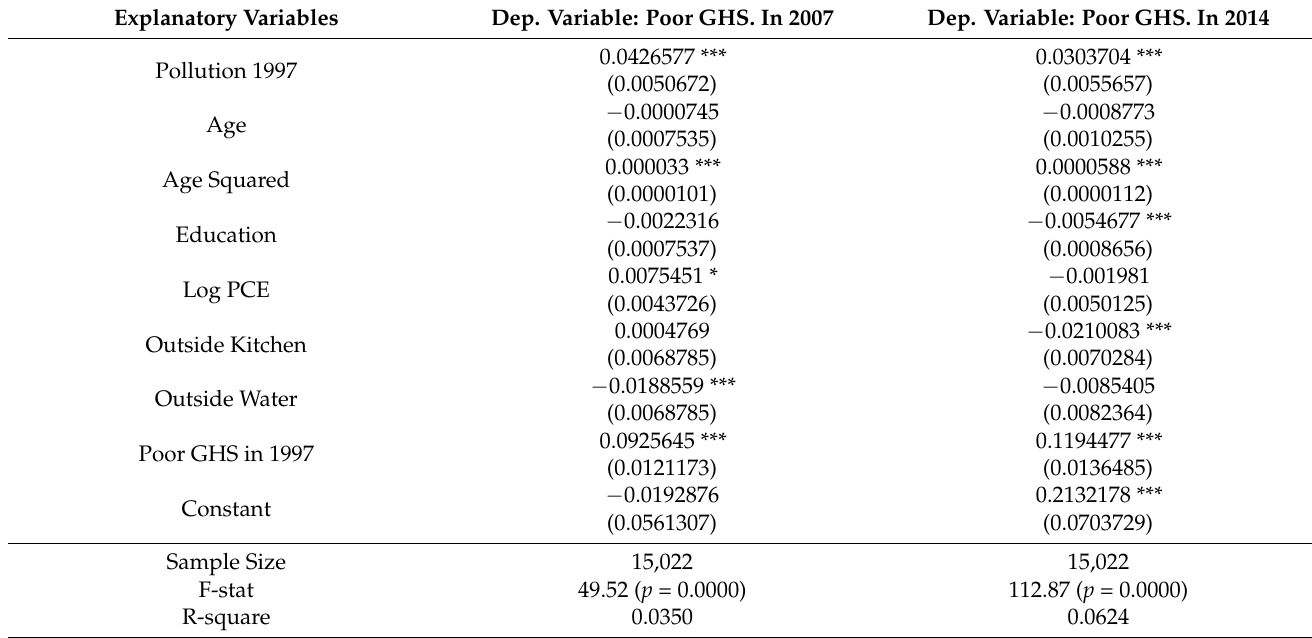
Table 2. General Health Status (GHS) Regression